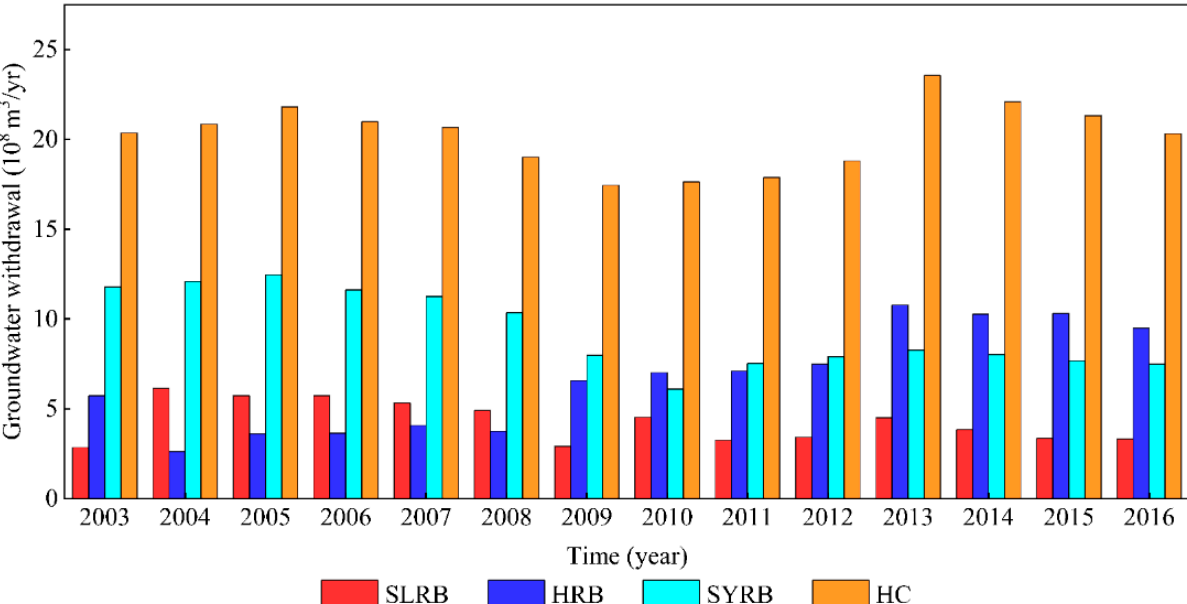
Figure 12. Time series of groundwater withdrawal in the HC and its three subregions.